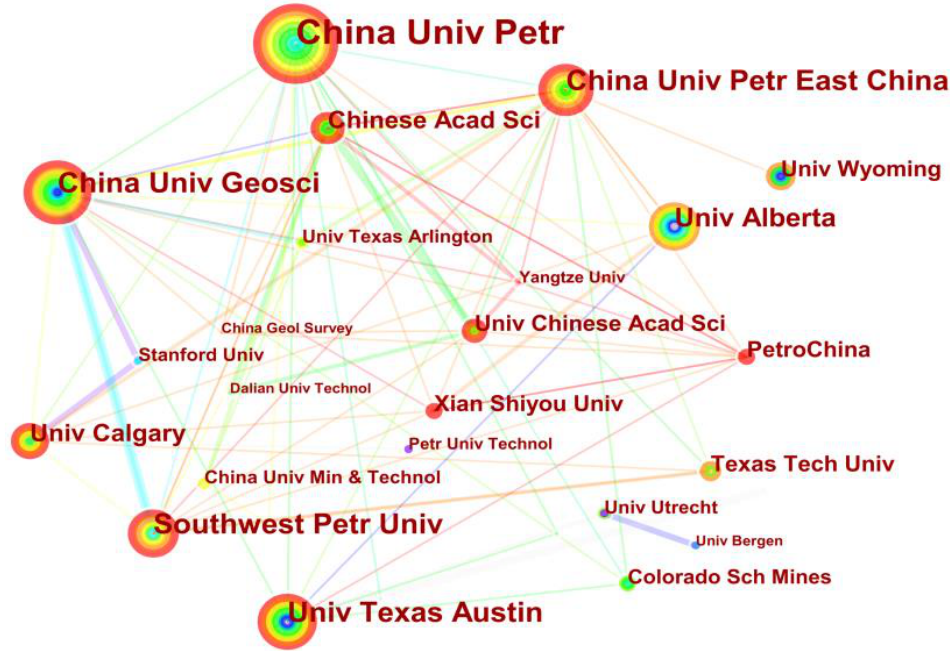
Figure 5. Institution cooperation network.